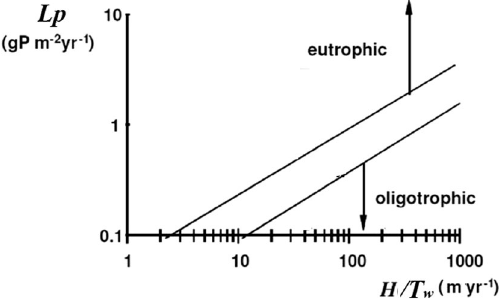
Fig. 4 Vollenweider trophic